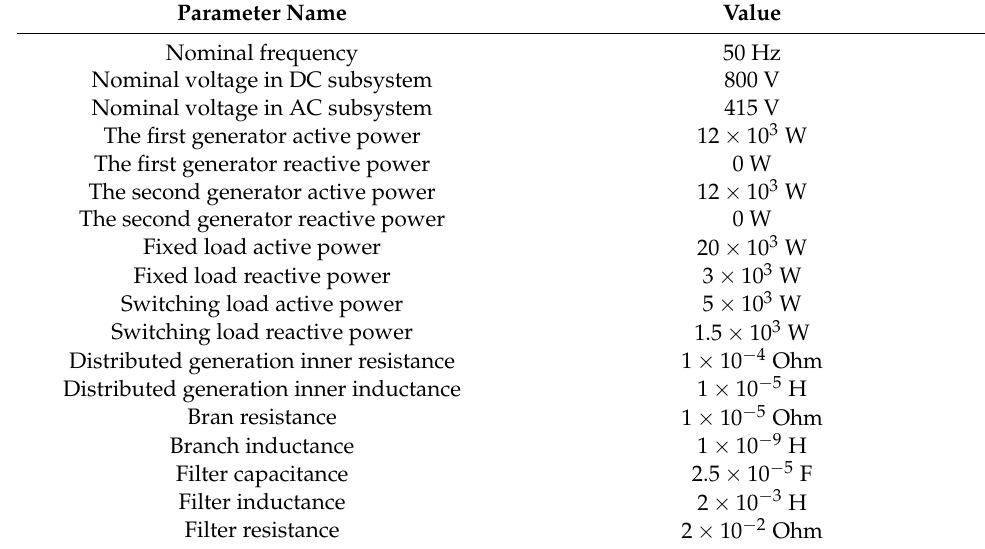
Table 1. Microgrid system parameters.